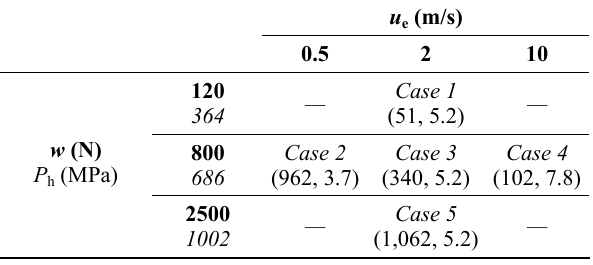
Table 1 Normal load, entrainment velocity (both in bold) and Hertzian contact pressure for the circular configuration (in italic) of the five reference cases. The ( M , L ) values are given under the Case